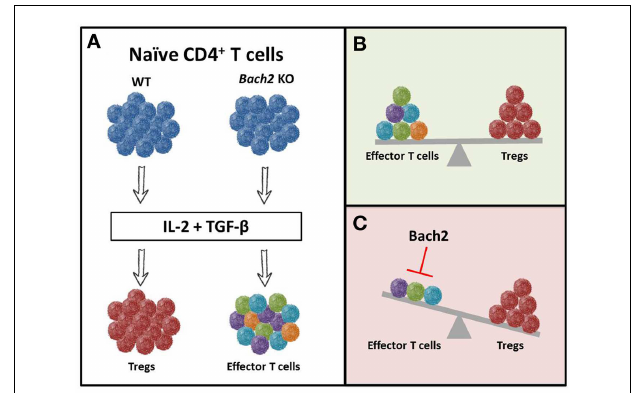
FIGURE 6 | Bach2 inhibitsT-effector differentiation and stabilizesTregs . Cytokines present in the environment regulate the phenotypic and functional fate ofT cells.The combination of IL-2 andTGF- β creates an environment conducive for the generation of inducibleTreg cells. (A) WT cells differentiated into FoxP3 + Treg cells when cultured with these cytokines, while Bach2 knockout cells converted into effectorT cells.This suggests that Bach2 is (B) an instrumental regulator of the immune system through (C) inhibition of effector function and thereby, stabilization